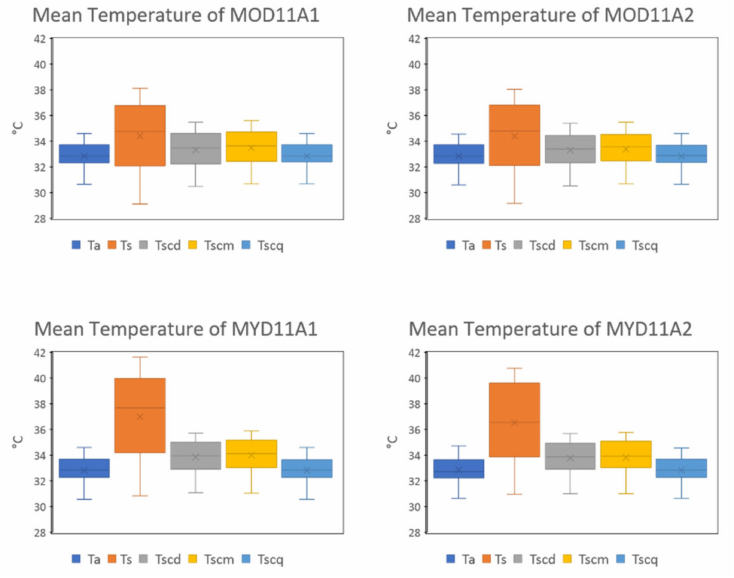
Figure 11. Comparison of average temperature value between T a , T s , T scd , T scm , and T scq for MOD11A1, MOD11A2, MYD11A1, and MYD11A2 across 36